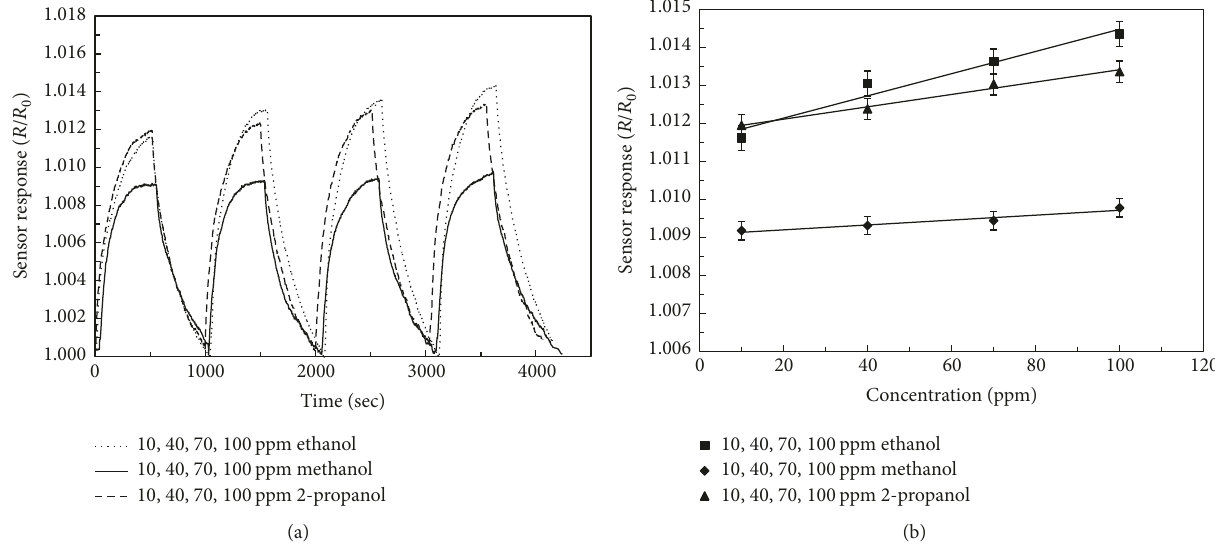
Figure 5: (a) Sensor responses to ethanol, methanol, and 2-propanol at a concentration range of 10 to 100ppm and (b) relationship between vapor concentrations and sensor